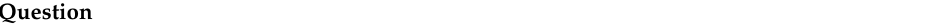
Table 2. The questioning route for both focus groups. During the focus group we asked participants to rank four management strategies and then discussed the results and reasoning behind these